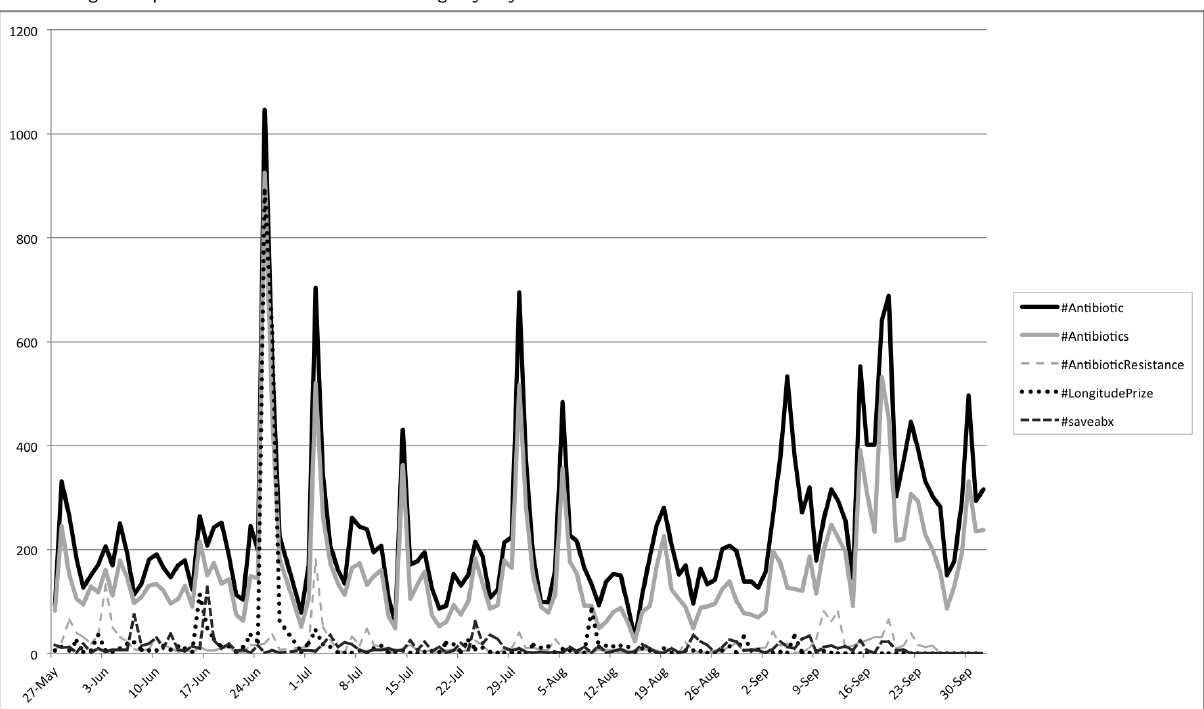
Figure 4. Usage of top overall antibiotic-related hashtags by